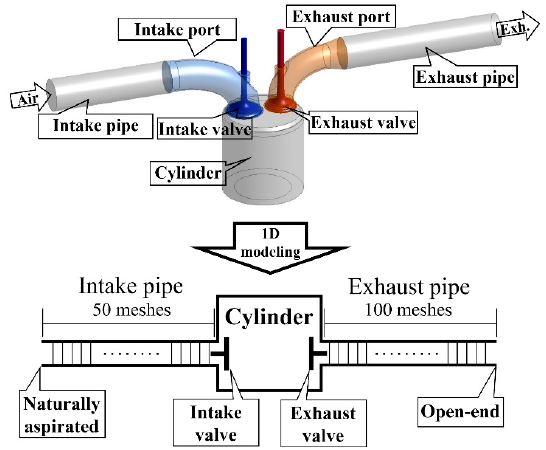
Figure 3. One-dimensional (1D) modeling of the gas flow analysis of a single cylinder diesel engine. J. Mar. Sci. Eng. 2020 , 8 , x FOR PEER REVIEW